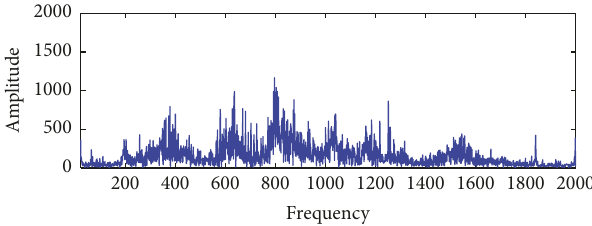
Figure 13: The FT of the vibration signal obtained from the fault gear.